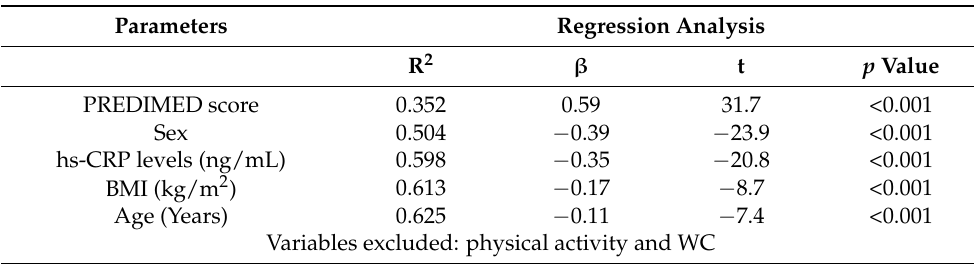
Table 5. Regression analysis model with the PhA as a dependent variable to estimate the predictive value of age, sex, physical activity, BMI, WC, hs-CRP level, and PREDIMED score.